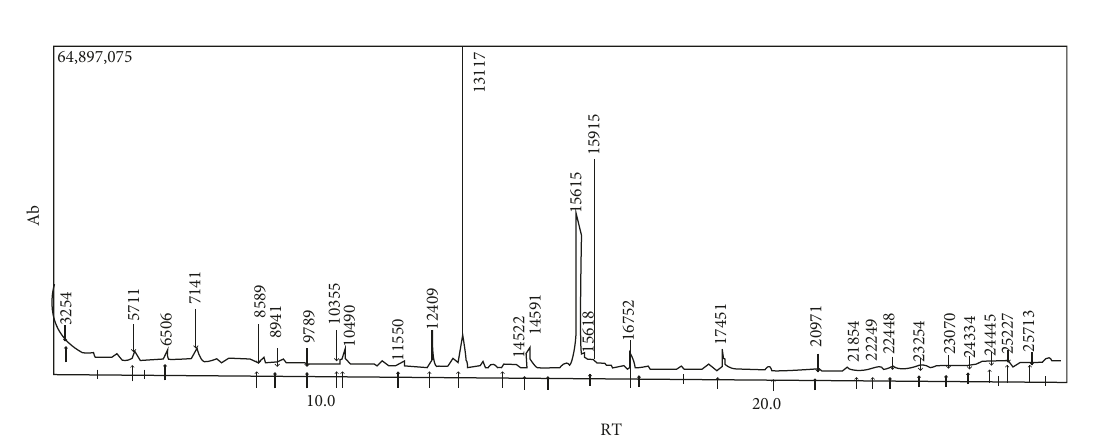
Figure 1: Spectra of the methanol bands. Major composition: hexadecanoic acid, methyl ester (13.117), methyl stearate (15.915), and 9- octadecenoic acid-methyl ester